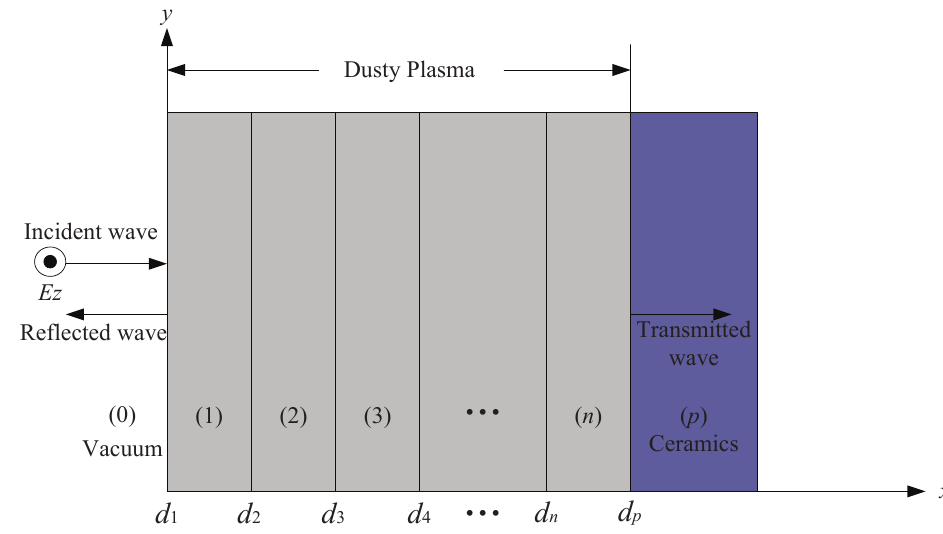
Figure 1. Propagation model of EM wave in inhomogeneous and collisional dusty